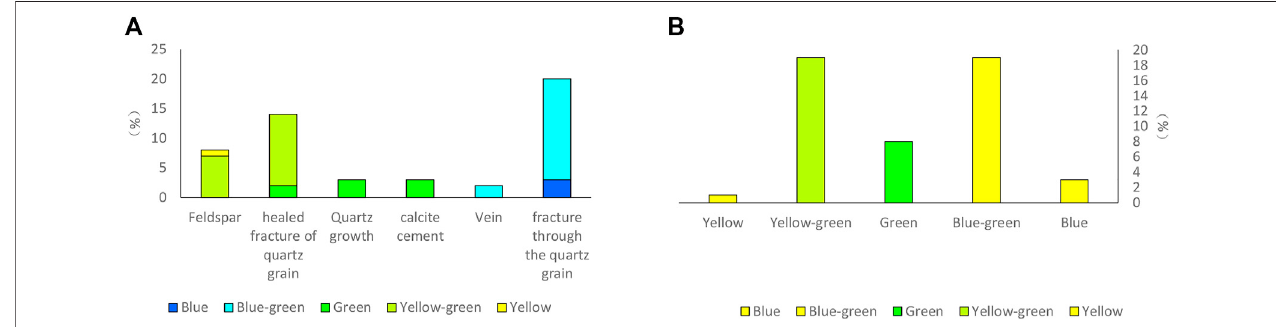
FIGURE 3 | (A) Histogram of oil inclusions in various diagenetic minerals. (B) : Histogram of numbers of oil inclusions with various